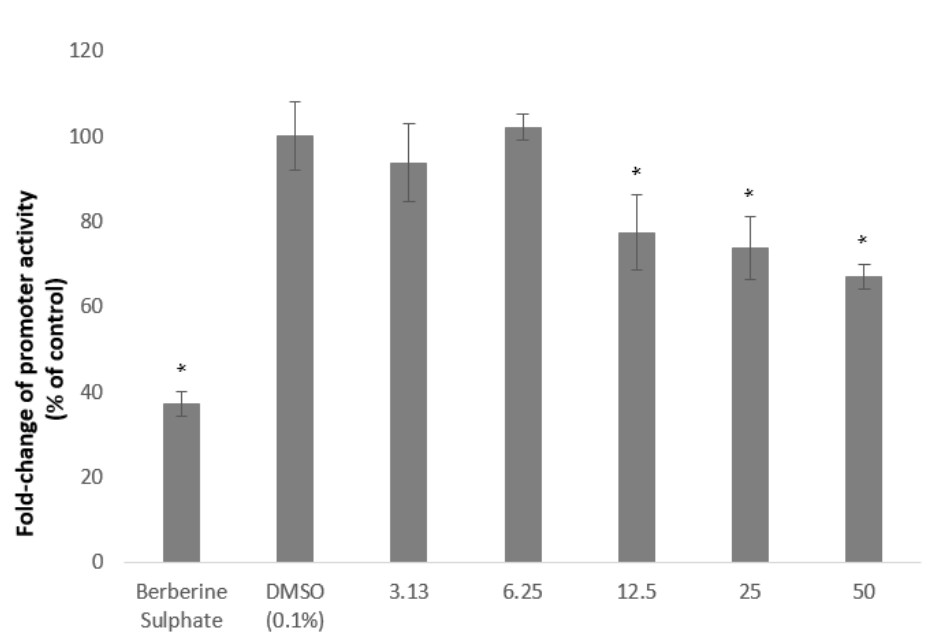
Figure 3. Luciferase activity of HepG2 cells transfected with PCSK9 promoter-reporter construct after 24 h treatment with A. planci methanolic extract. The cells were treated at various concentrations from 3.13 to 50 µ g/mL. Data presented as mean ± SD with n = 6. The value at each point represents the fold change of normalised PCSK9 promoter activity relative to the untreated control which was assigned as 100%. * denotes significantly different as compared to DMSO-treated cells (negative control) at p < 0.05. DMSO was used as the carrier to dissolve and dilute the extract.